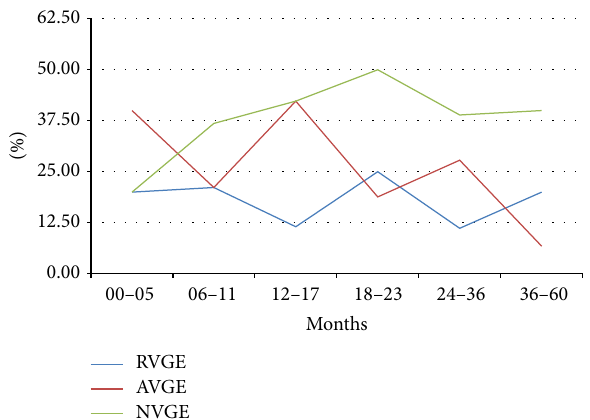
Figure 7: Proportion of cases with family members affected during RVGE, AVGE, and NVGE episodes stratified by